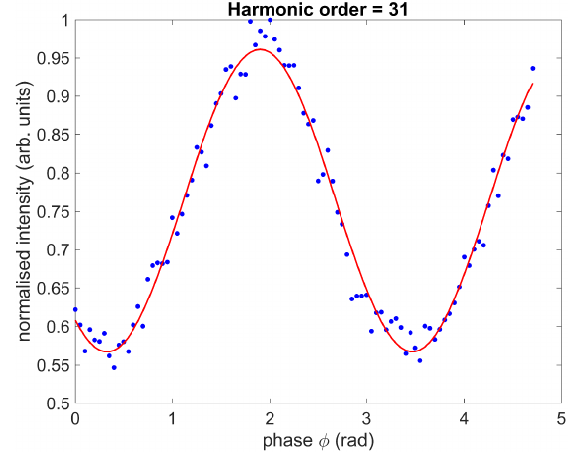
Figure 7. Intensity oscillation of harmonic order 31 while scanning the two-colour phase ϕ . Blue dots are extracted from Figure 6A, the red line is the fit of Equation